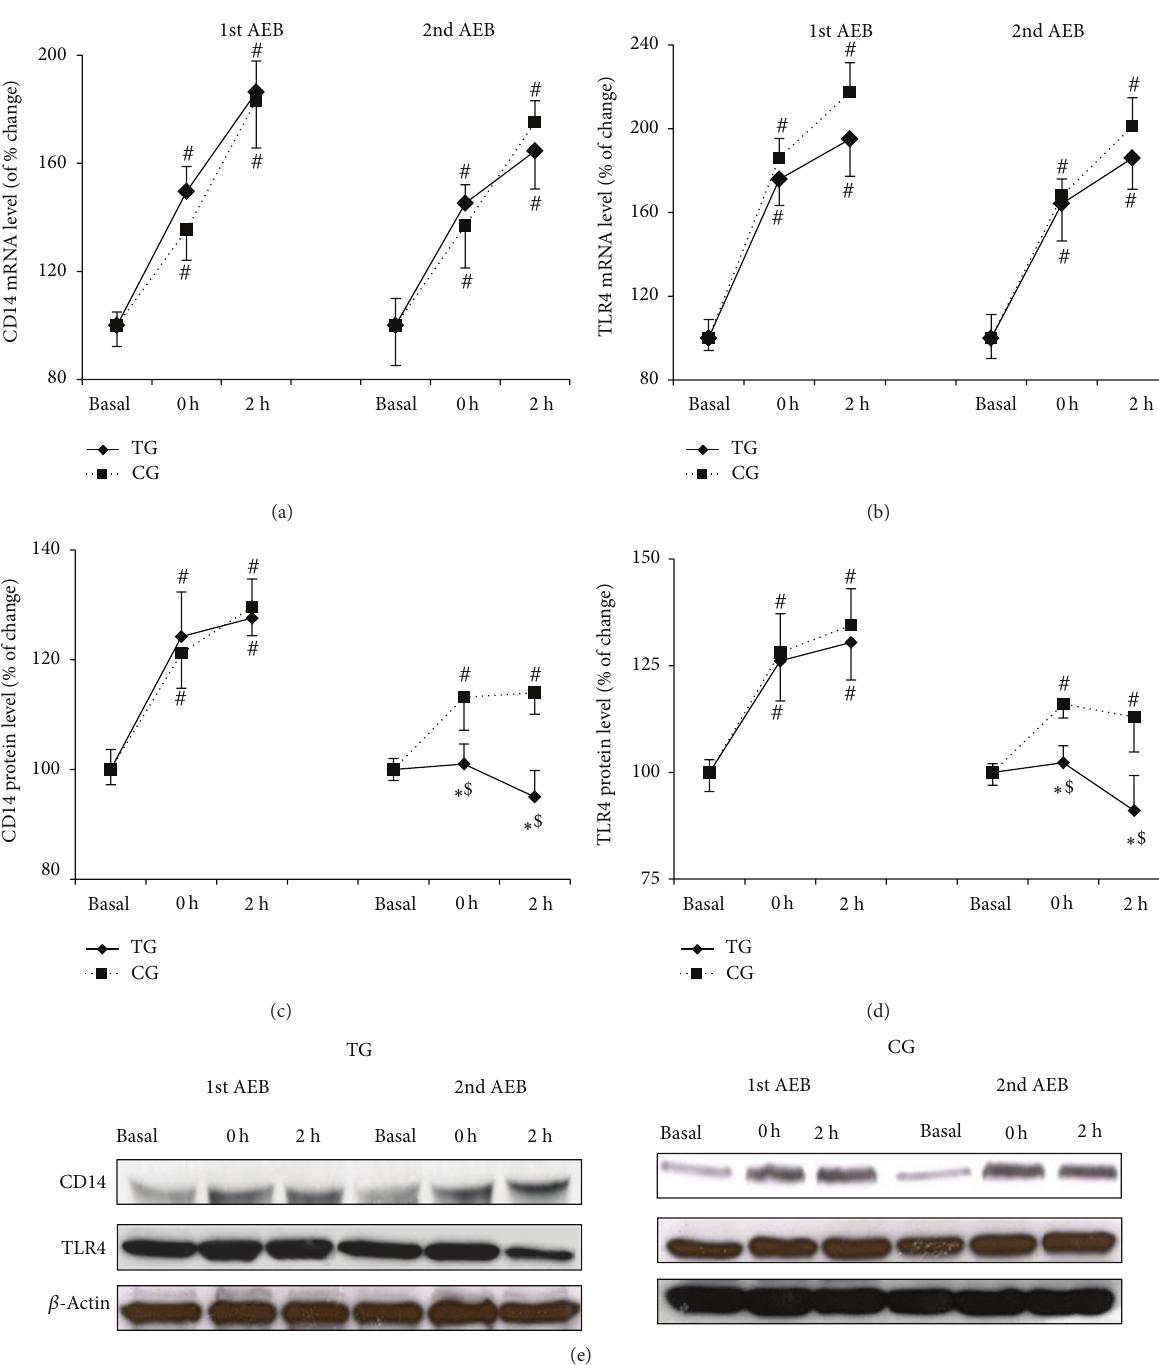
Figure 1: Training reduces CD14 and TLR4 protein overexpression induced by acute eccentric exercise. CD14 (a) and TLR4 (b) mRNA levels, CD14 (c) and TLR4 (d) protein contents after the first and the second acute eccentric bout (AEB) for training group (TG, solid line) and control group (CG, dotted line), and representative Western blots (e). Mean ± SEM. ∗ 𝑃 < 0.05 versus CG; # 𝑃 < 0.05 versus basal value, same group; $ 𝑃 < 0.05 versus 1st acute eccentric bout, same